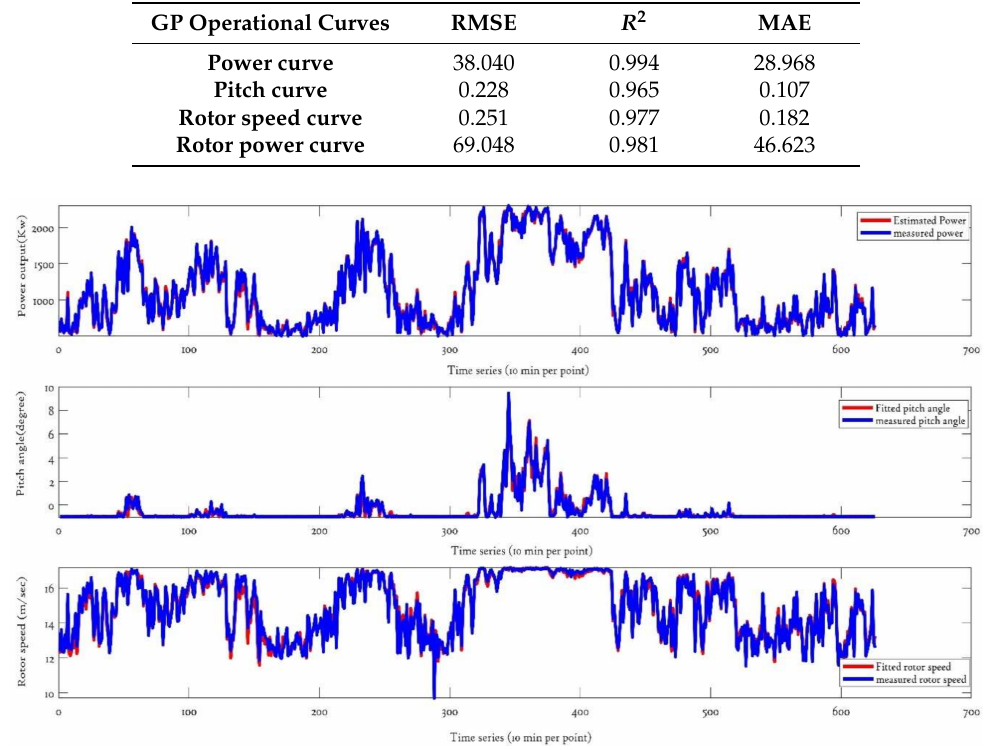
Figure 21. Comparative studies of measured and estimated operational curves in time